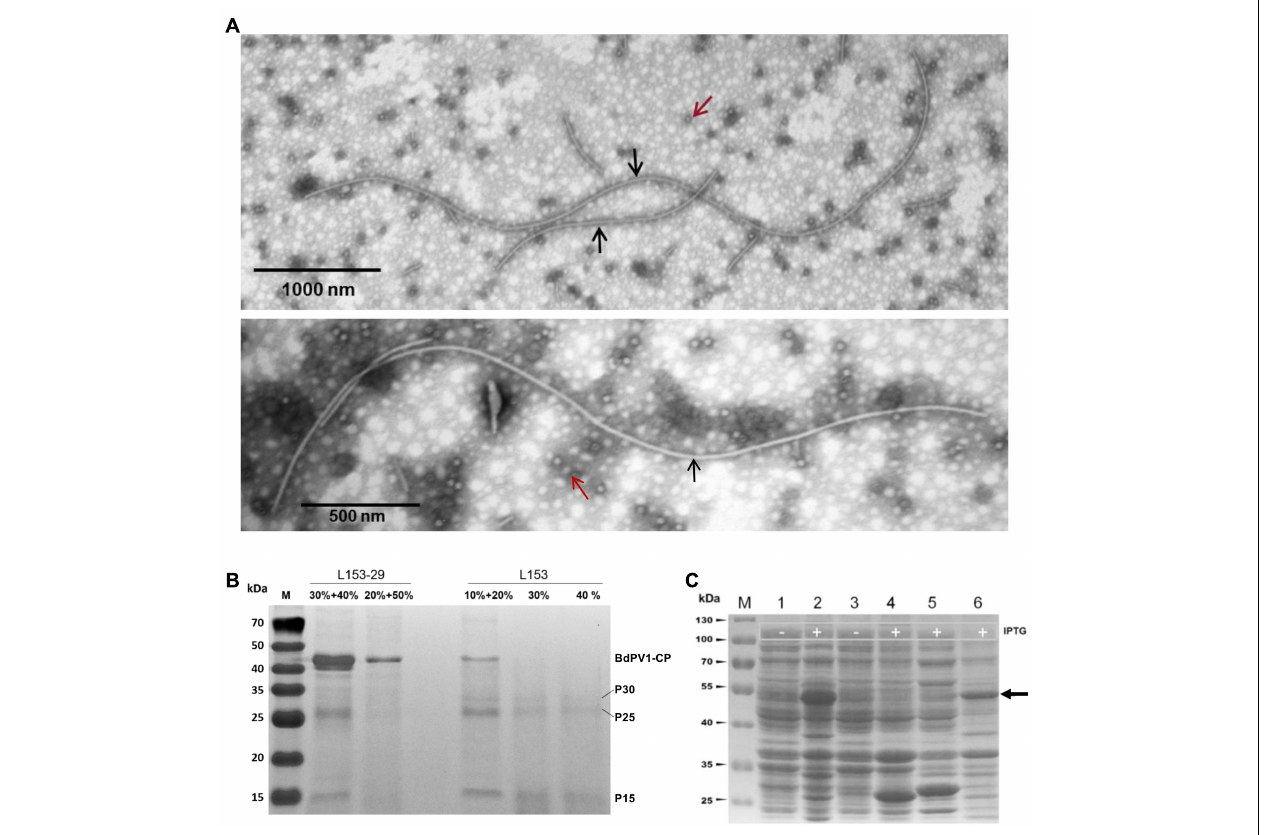
FIGURE 5 | Transmission electron microscopy (TEM) analysis of virus particles and SDS-PAGE analysis of viral and prokaryotic expressed fusion proteins using 12% gel. (A) TEM images of virus particles purified from strain L153. Two types of isometric and filamentous particles were observed and indicated by red and black arrows, respectively. (B) SDS-PAGE analysis of virus preparations in different sucrose gradients of strains L153-29 and L153. (C) SDS-PAGE analysis of expression of fusion proteins in E. coli was induced at 28 ◦ C overnight. Lines 1 and 2, uninduced and induced E. coli transformed with plasmid pGEX-BdBV1-ORF5. Lanes 3 and 4, uninduced and induced E. coli transformed with plasmid plasmid pGEX-KG. Lane 4, induced E. coli transformed with plasmid pGEX-KG. Lanes 5 and 6, supernatant and precipitated proteins of induced E. coli transformed with plasmid pGEX-BdBV1-ORF5 after sonication. Target protein band was indicated by black